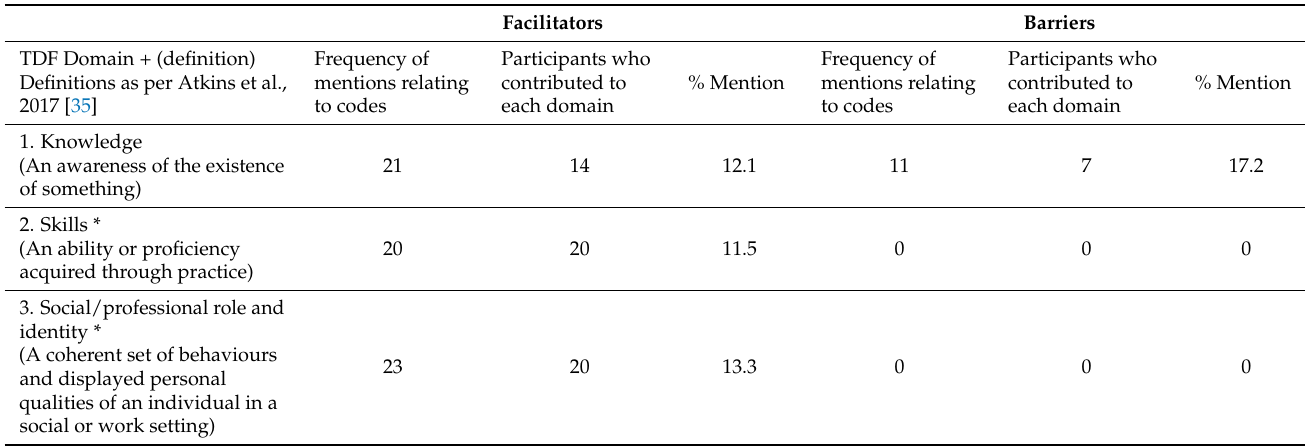
Table 3. Frequency of responses mapped to each TDF